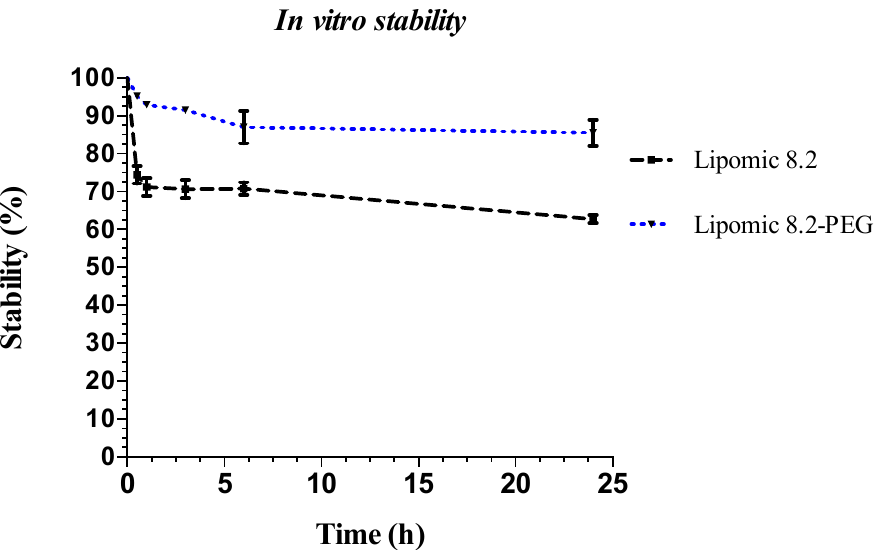
Figure 7. In vitro stability in serum of 99m Tc lipomics (formulation 8.2). The graph plots the mean value +/ − standard deviation of three repetitions.